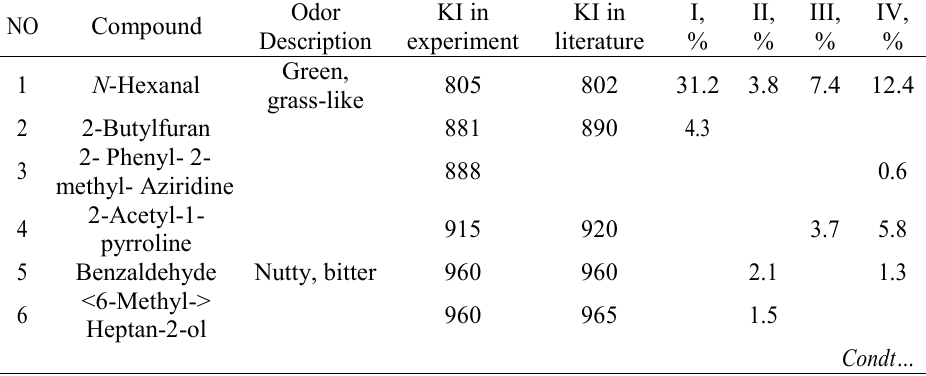
Table 1. Flavor volatiles identified in headspace of Hashemi rice